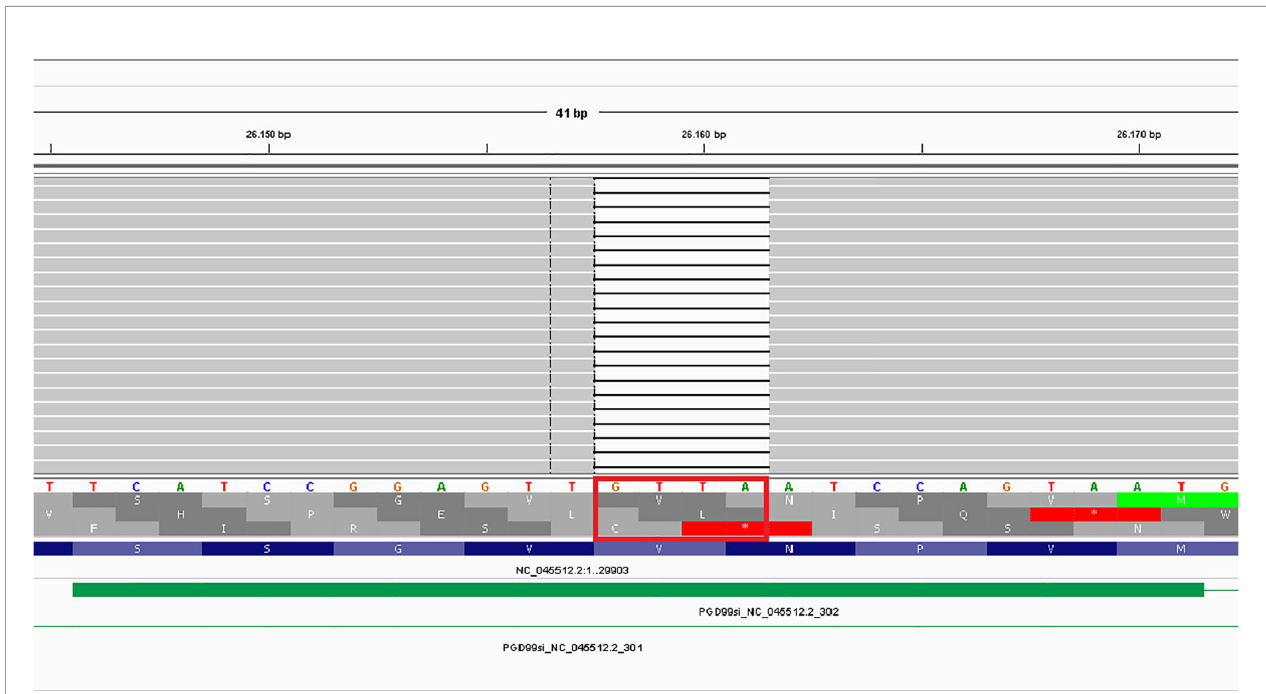
FIGURE 1 | IGV representation of the c.766_769del affecting the ORF3a gene.